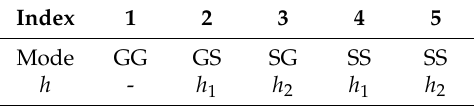
Table 4. Index of propagation